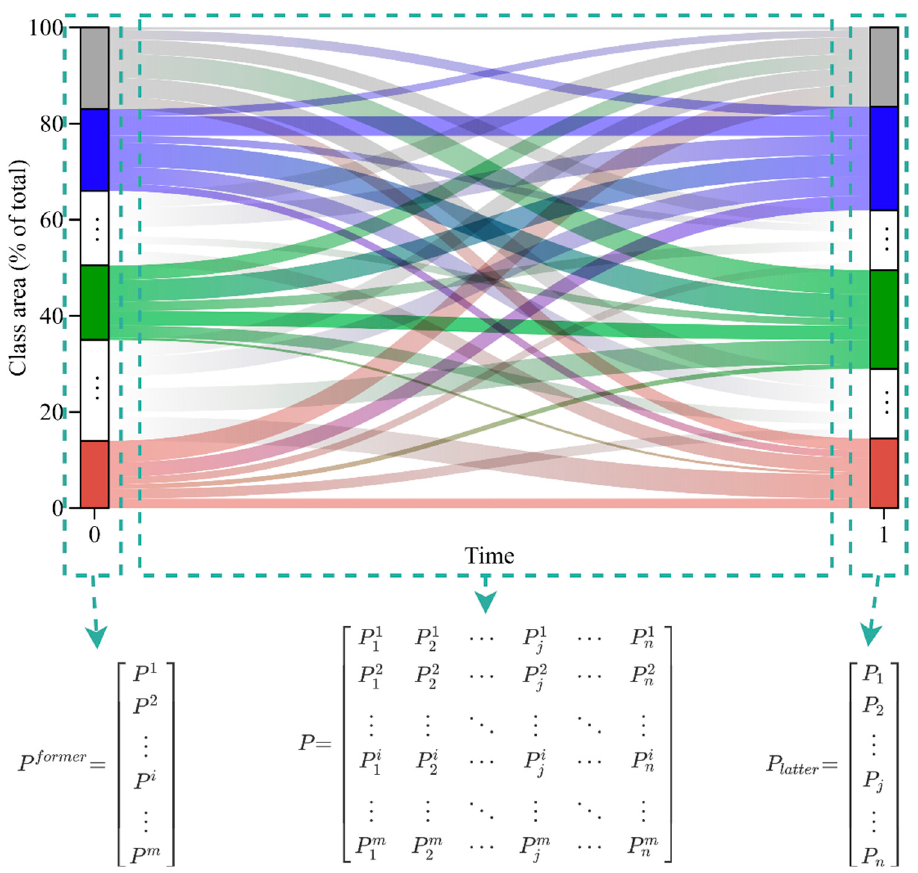
Figure 3. An illustration of the modified Sankey chart. The number of land use types at 0 ‐ time and 1 ‐ time is assumed to be the same here.